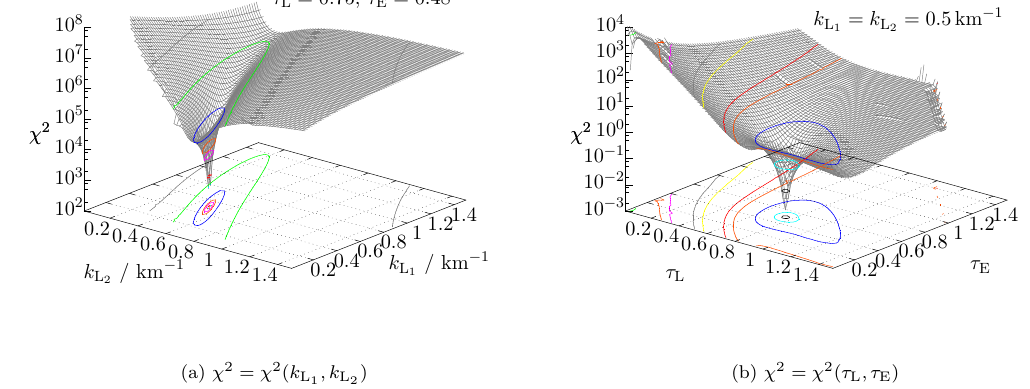
Fig. 5. Error-free least-squares object function (residual) χ 2 ( x ) , Eq. (7), for the well-mixed ground layer with τ ∼ 1.2 (Fig. 2) represented by the four parameters k L , k L , τ L and τ E , Eq. (15). (a) For constant τ L , τ E , and (b) for constant k L 1 2 and θ ∼ 10 ◦ , φ rel ∼ 170 ◦ .